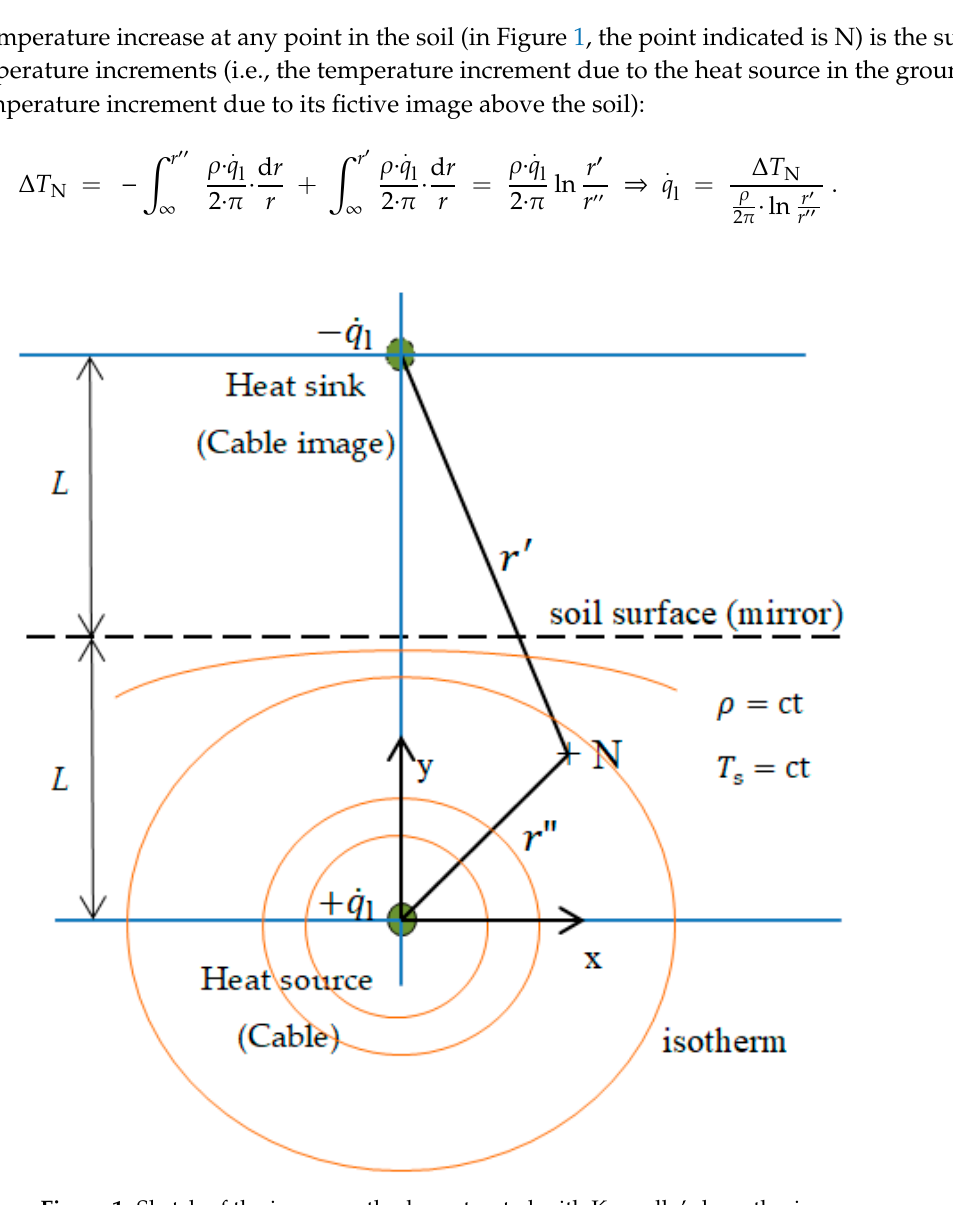
Figure 1. Sketch of the image method constructed with Kennelly’s hypothesis.